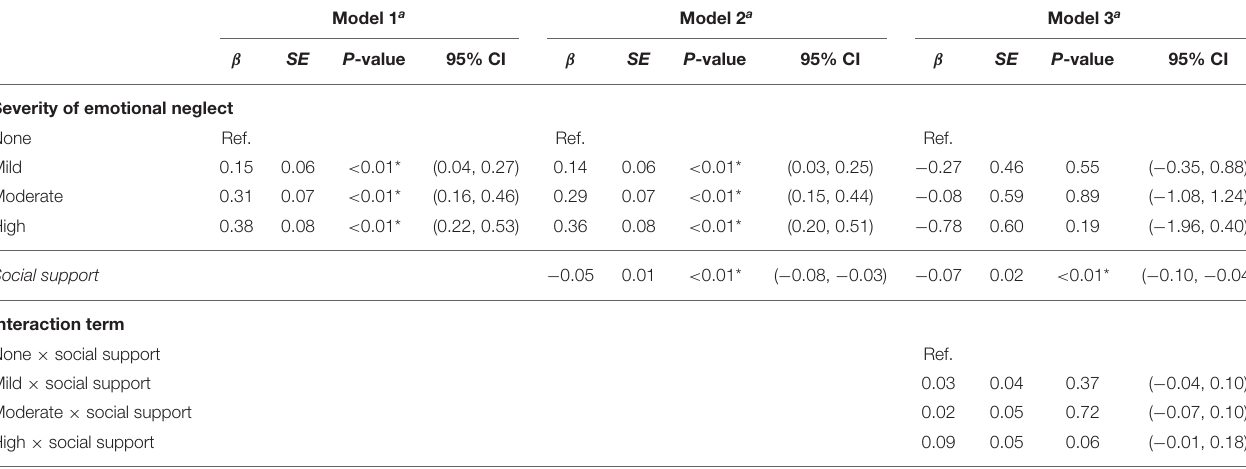
TABLE 3 | Results of linear regression analysis assessing the association between degree of severity of childhood emotional neglect on depressive symptoms at age 18, adjusting for